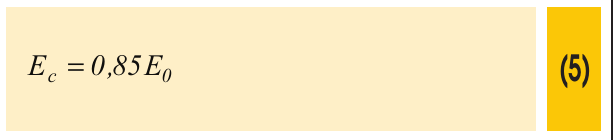
Figure 2 – Ultimate stress envelop for concrete in biaxial state of